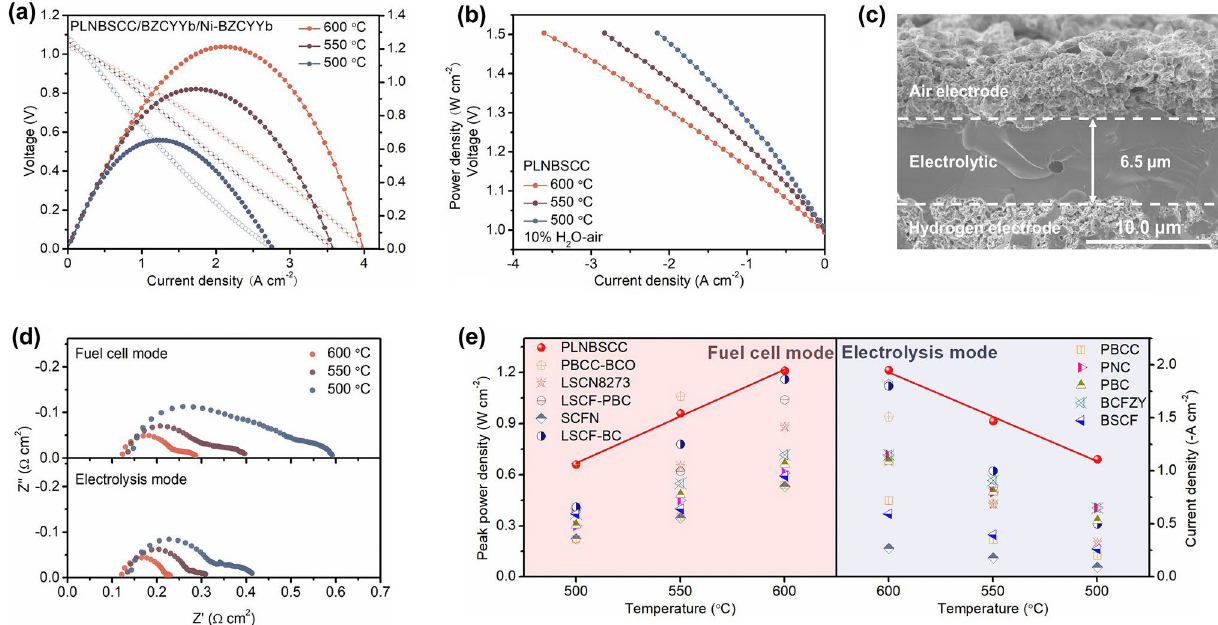
Fig. 5 The single-cell structure was optimized by a spin-coating method to prepare thinner electrolyte layer and obtain excellent electrochemi- cal performance. a I – V and power density curves during fuel cell operation and b I – V curves during electrolysis operation (10% H 2 O–air) were measured using an R-PCEC with high-entropy PLNBSCC air electrode at 500–600 °C. c Cross-sectional SEM image of single cell. d EIS curves of a single cell in fuel cell (open circuit voltage) and electrolysis modes (1.3 V) at 500–600 °C. e The peak power densities and current densities obtained by R-PCEC with PLNBSCC air electrode in fuel cell and electrolysis modes compared with some reported air electrode